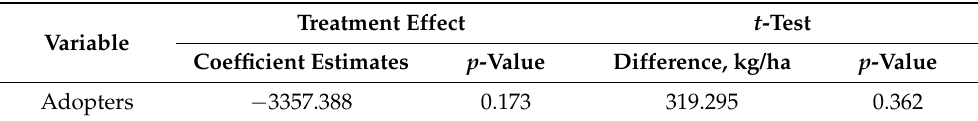
Table 5. Effect of AWD adoption on